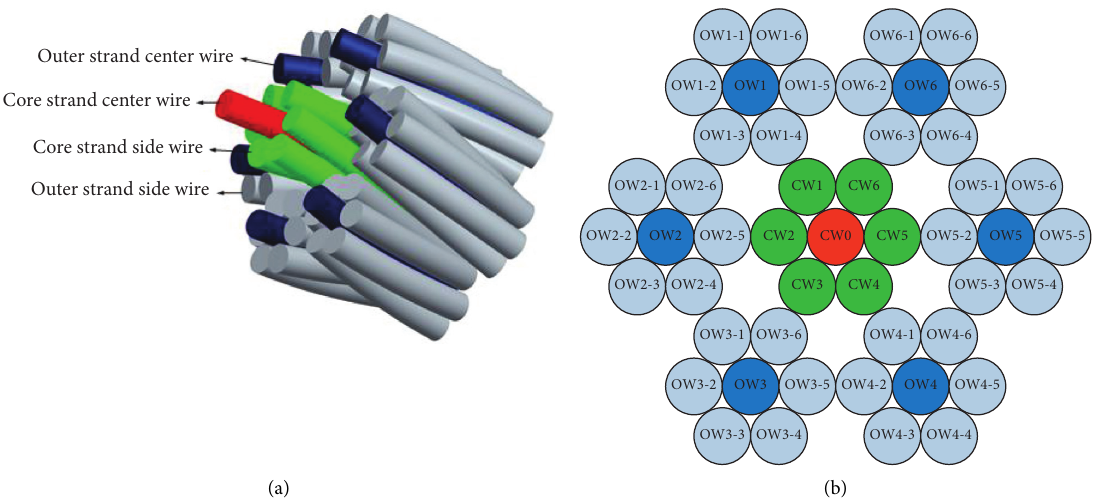
Figure 6: 6 × 7 +IWS wire name and number. (a) 6 × 7 +IWS wire rope, four types of steel wire naming. (b) Wire number.